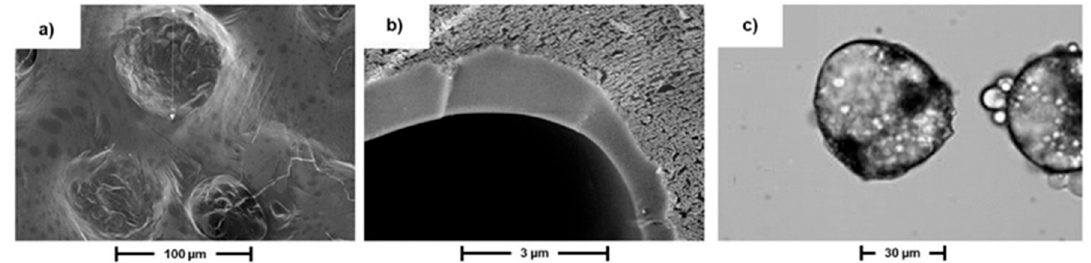
Figure 3. SEM analysis of MC3 surface ( a ) and cross-section ( b ) and optical micrographs showing MC3 internal morphology ( c ).